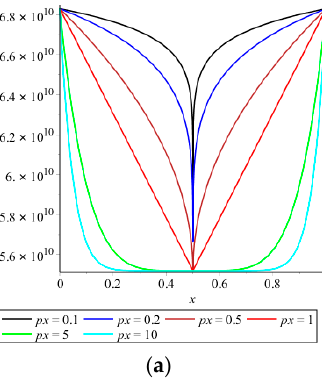
( b ) Figure A1. Young’s modulus evolution [Pa] of ( a ) FGM1-Z; ( b ) FGM2-Z. Similarly for the density, and for the same two cases (Equations (3) and (4)), the pro- files are depicted in Figure A2. ( a ) ( b )